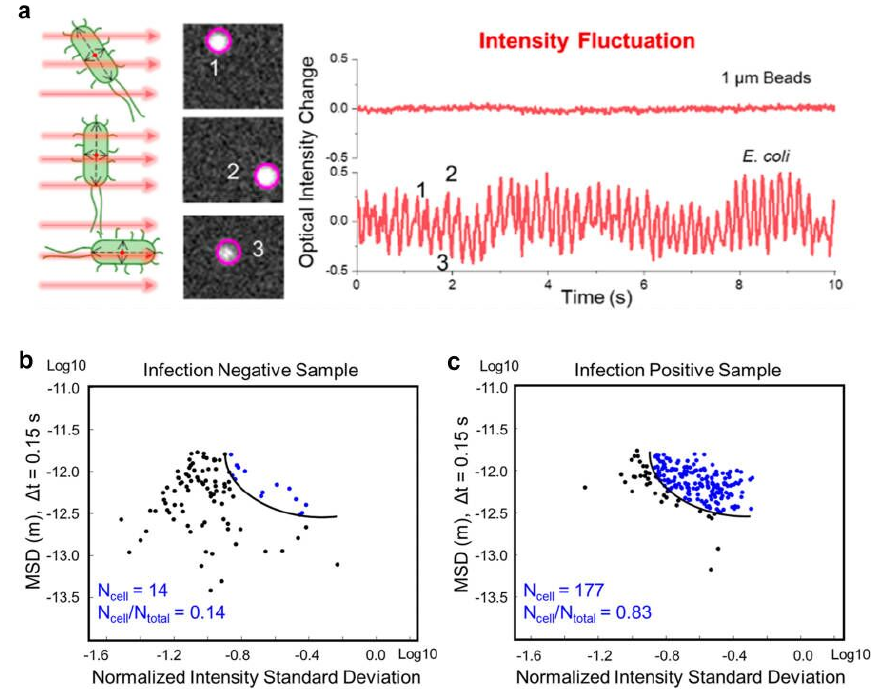
Figure 8. The principle of tracking the rapid identification of 1 um polystyrene spheres and single cell phenotypic characteristics of E. coli . ( a ) E. coli rotation-induced scattering intensity fluctuation tracking compared with 1 µ m microbeads. ( b ) SVM classification result of one representative infection negative sample. ( c ) SVM classification result of one representative infection positive sample. [122]. Adapted with permission from Ref. [122]. Copyright © 2022 American Chemical Society.